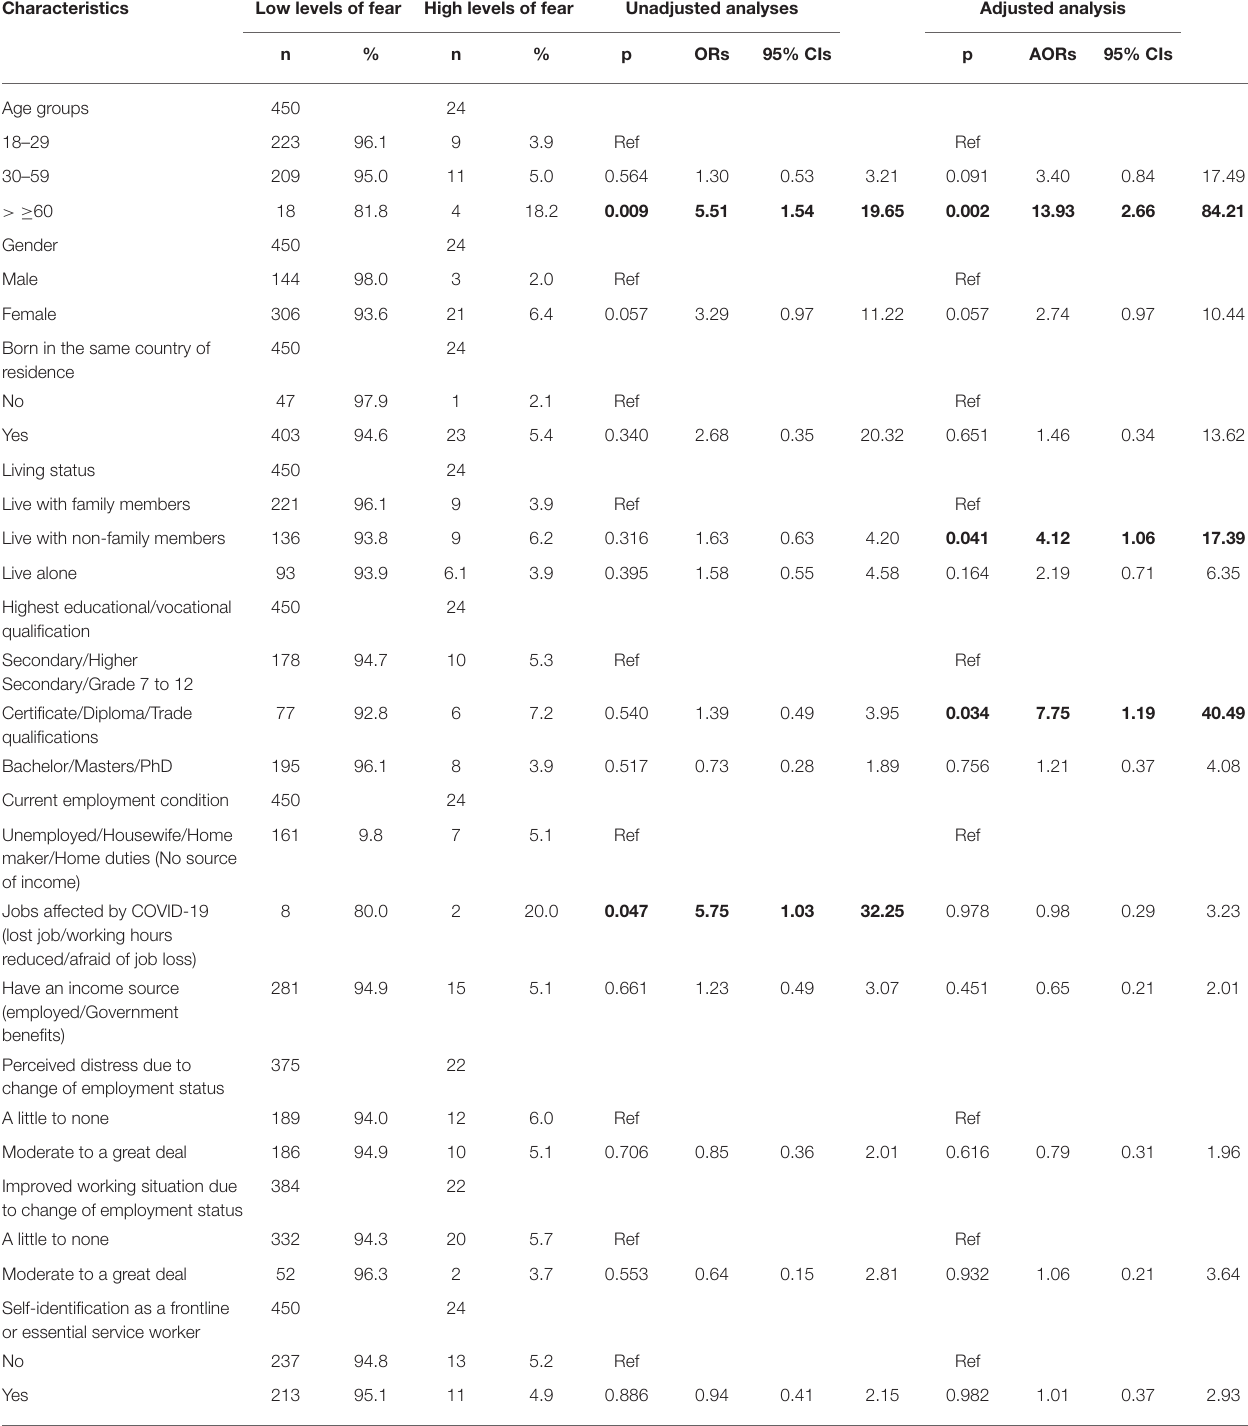
TABLE 3 | Factors associated with high levels of fear of COVID-19 among the study population (based on FCV-19S scoring). Characteristics Low levels of fear High levels of fear Unadjusted analyses Adjusted